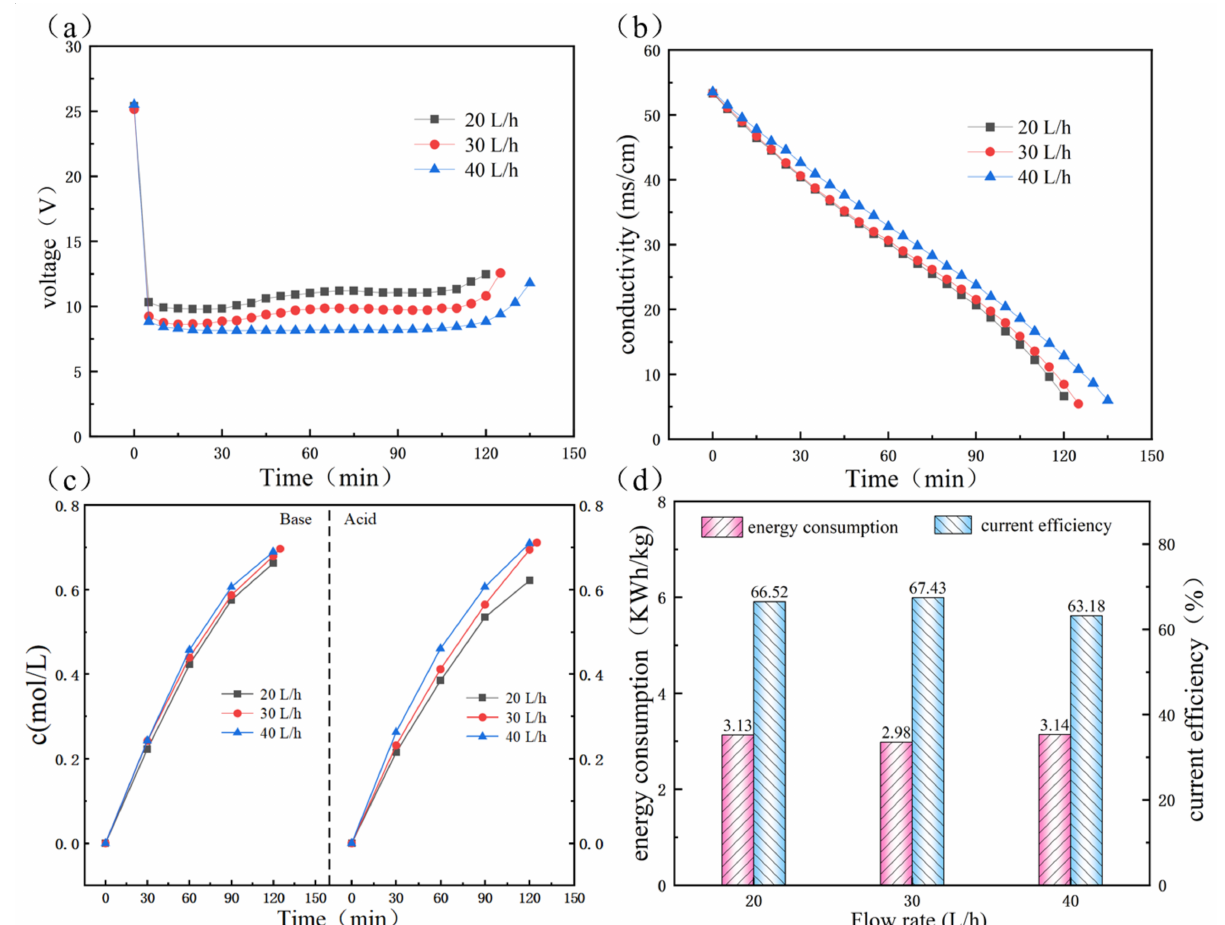
Figure 9. Effect of flow velocity on ( a ) membrane stack voltage; ( b ) conductivity of feed compartment; ( c ) the concentrations of acid and base; ( d ) current efficiency and energy consumption. The feed conductivity: 55 mS/cm; current density: 20 mA/cm 2 ; initial HCl and NaOH contents: 0.10